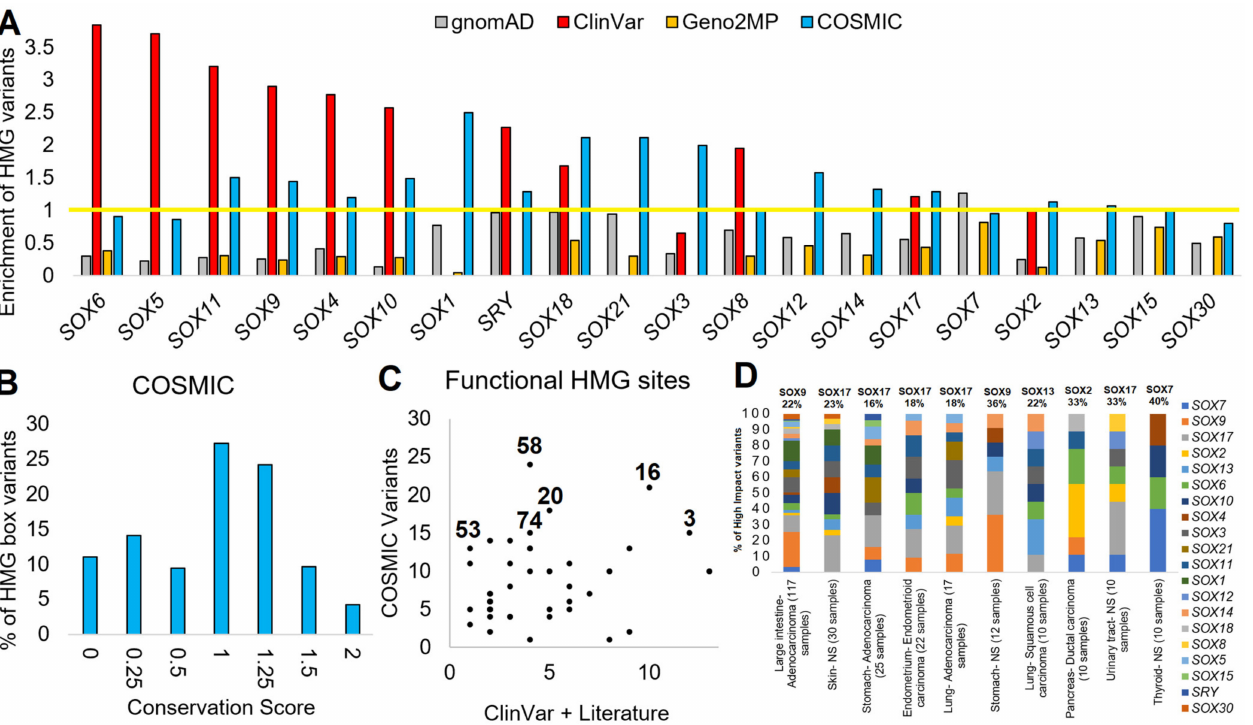
Figure 7. COSMIC variants of SOX genes. ( A ) Enrichment of variants within the HMG box for each SOX protein for gnomAD (gray), ClinVar (red), Geno2MP (orange), or COSMIC (cyan). Genes are ranked based on the highest enrichment for any database. The enrichment was calculated by normalizing the HMG box size relative to the total protein such that a value of 1 (yellow line) is the random probability of a variant falling within the HMG box. ( B ) Codon selection score of variants from COSMIC that fall with the HMG domain. ( C ) Amino acids found with ClinVar or annotations in the literature (x-axis) associated with disease for the HMG box that have COSMIC variants (y-axis) ( D ) Annotation of HMG box variants from panel ( C ) showing tissue type and histology annotations for each protein of the top-10 tumor types. The number of COSMIC samples with each cancer type with high-impact variants is shown on the x-axis labels. The top SOX gene for the percent of variants is labeled on top of each